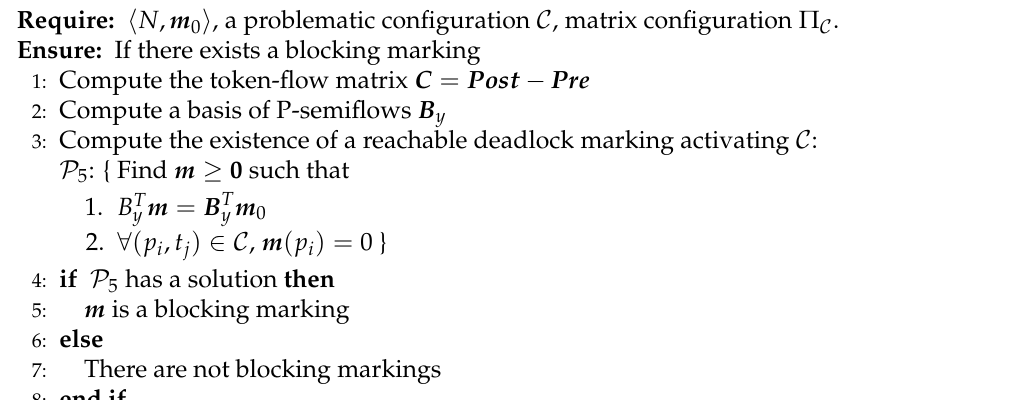
Algorithm 5 Computing if there exists a deadlock marking in a given